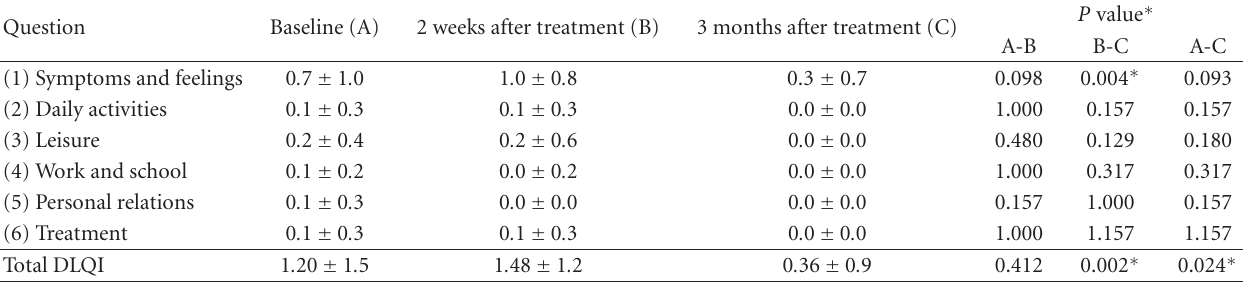
Table 2: Change in DLQI and subcategories over time among 25 BCC patients treated by X-ray.